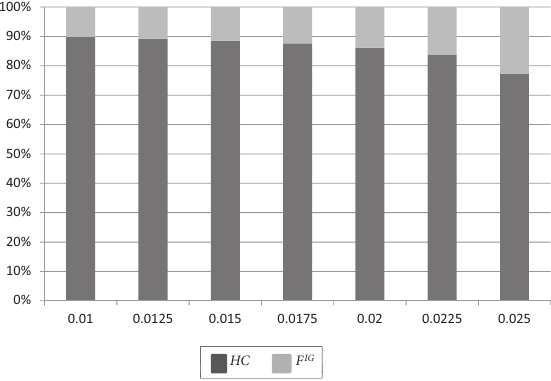
Figure 5. Housing value composition and risk-free rate